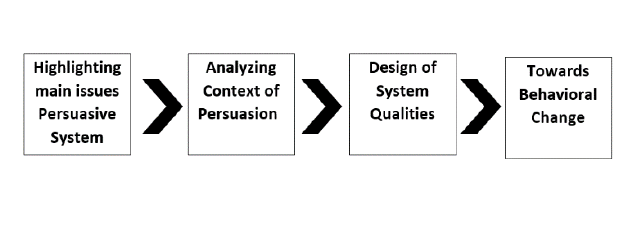
Figure 1 : Development Phase of Persuasive